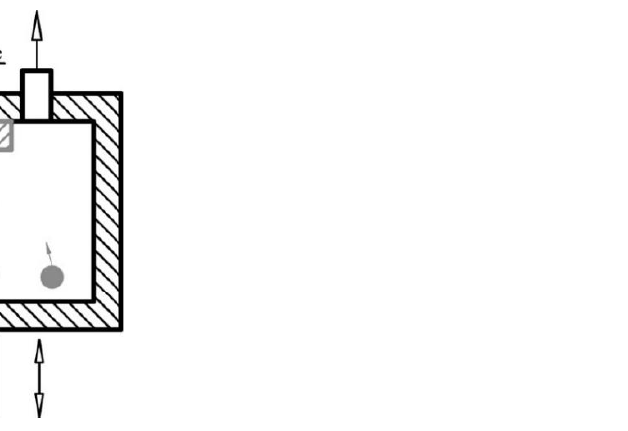
Figure 2. Illustration of SMAT treatment. Reprinted with permission from Ref. [17]. Copyright 2008 Elsevier.